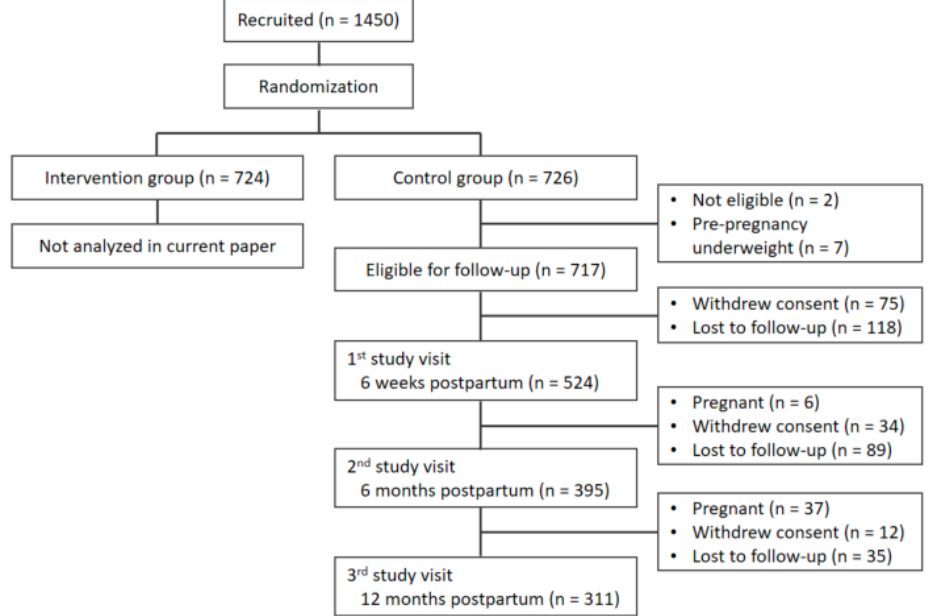
Figure 1. Flow chart of participant